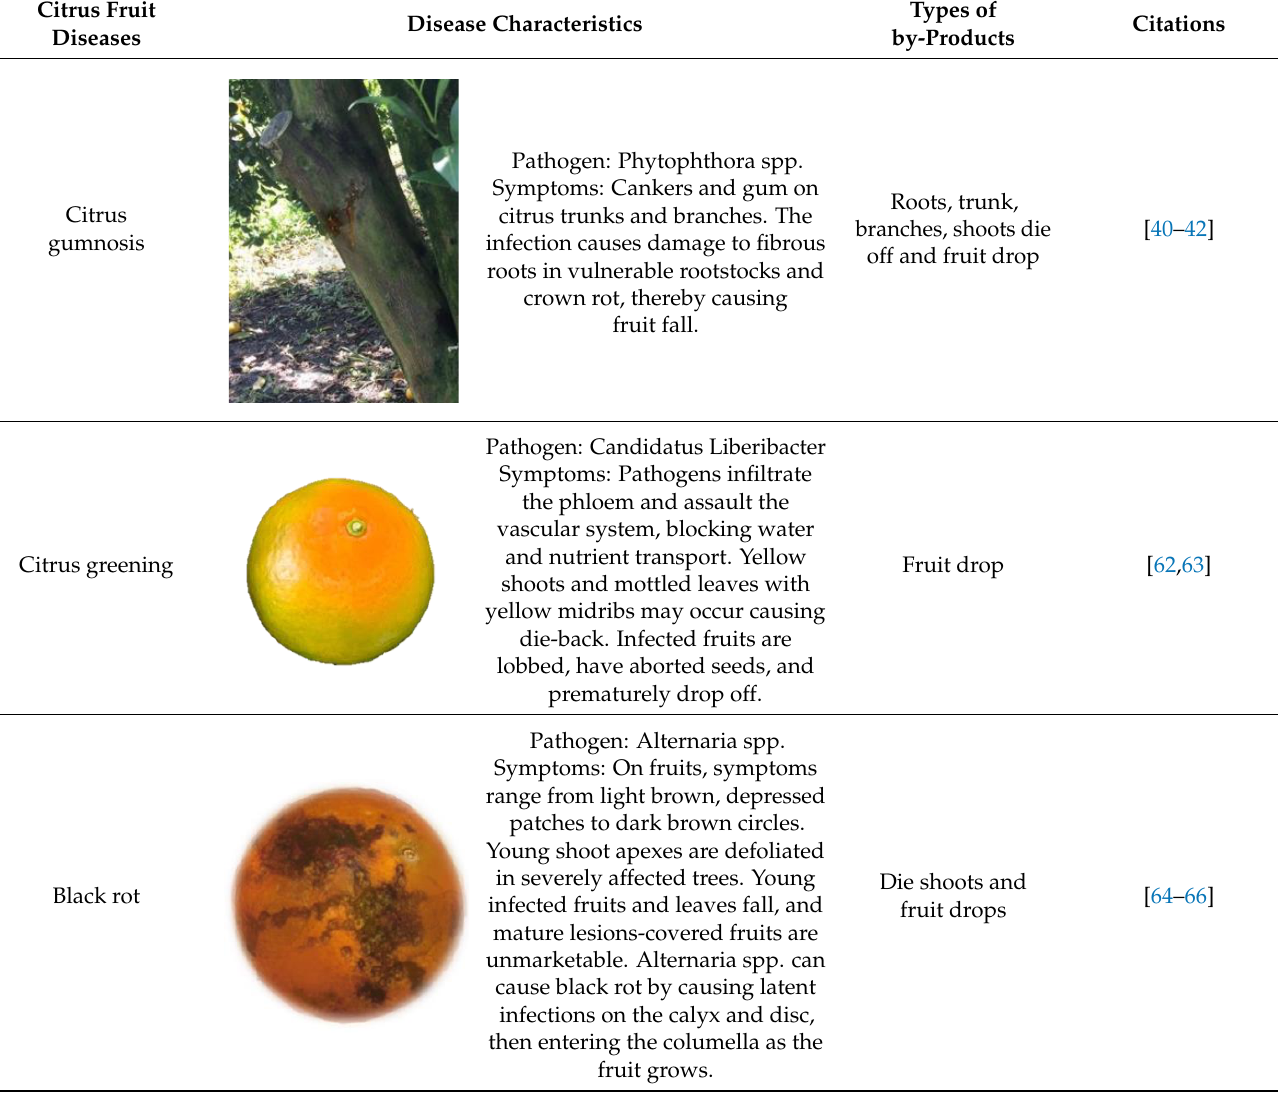
Table 1. Causes of losses and types of by-products during the production of citrus fruits.